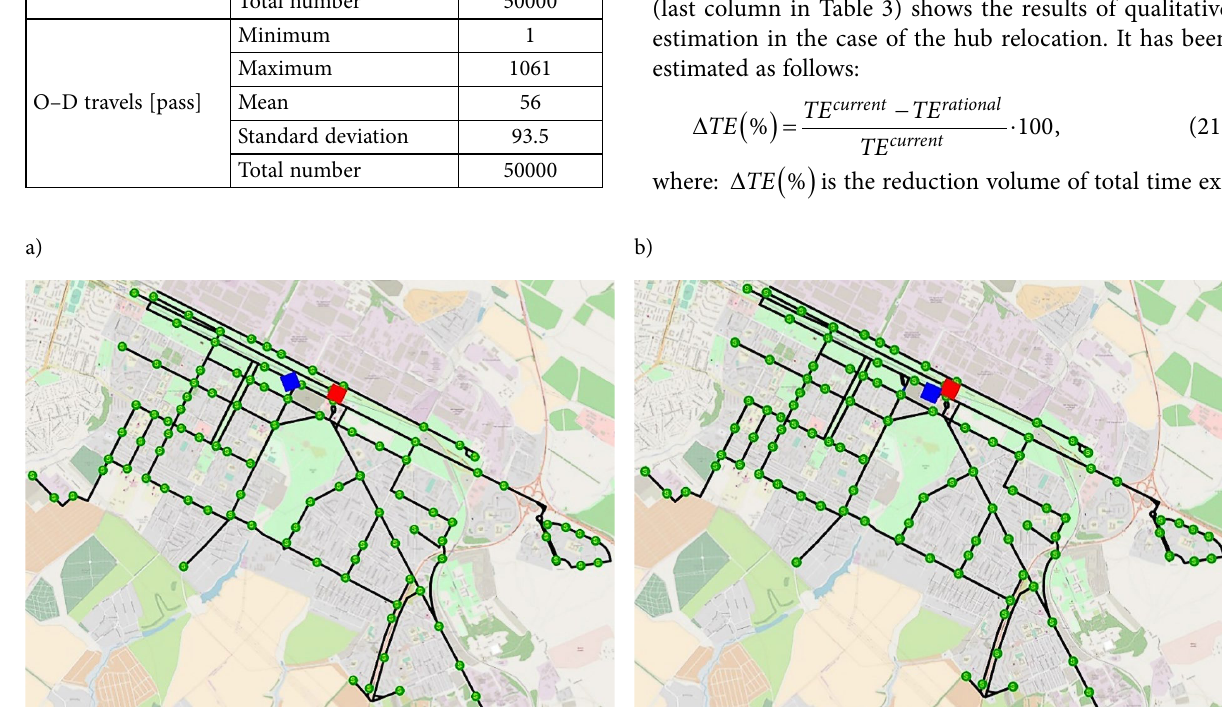
Figure 5. Current (a) and proposed (b) locations of transport hub in the Kharkiv City’s Industrial Table 3. Results of trip time simulation (source: research by